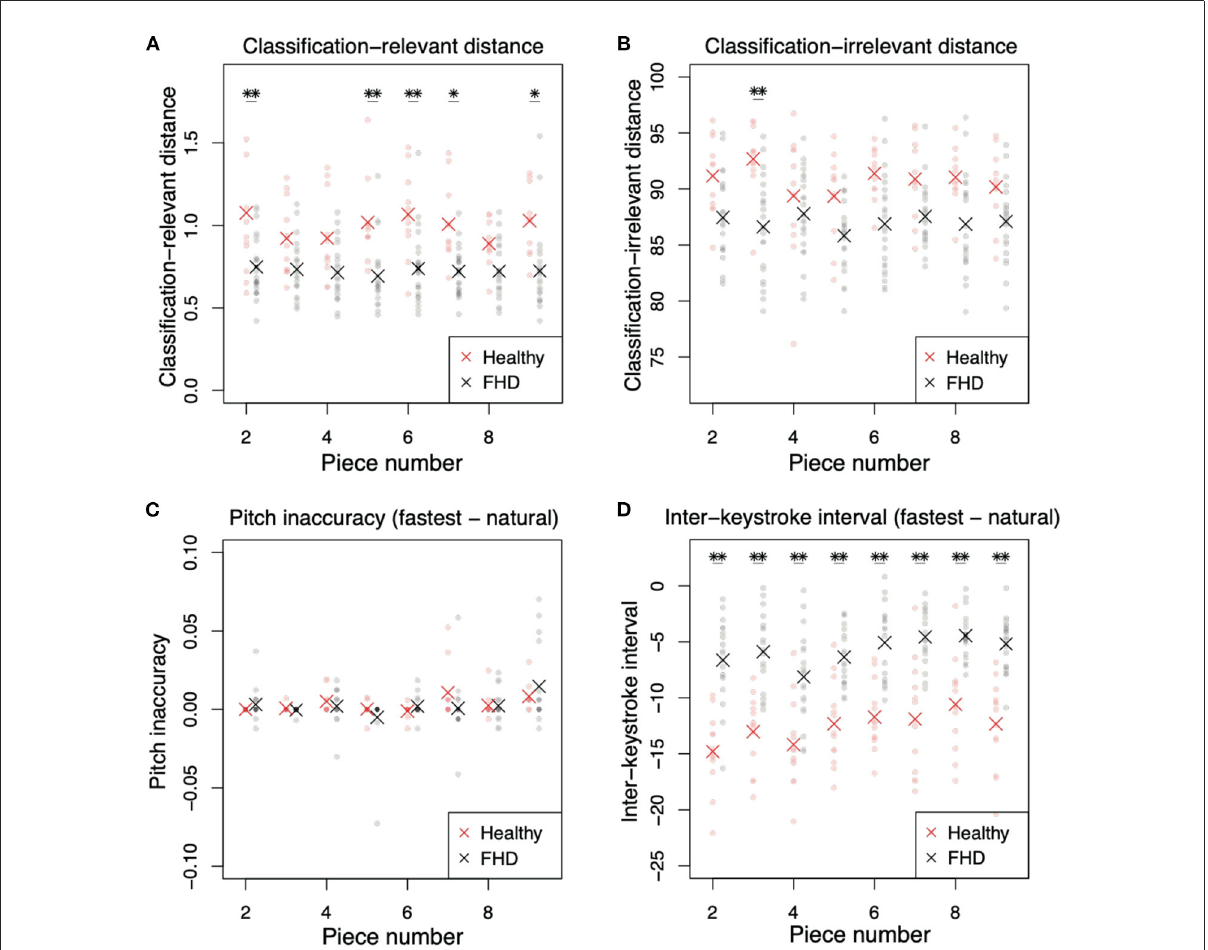
FIGURE6 Comparisons of classification-relevant distance, classification-irrelevant distance, pitch inaccuracy, and interkeystroke interval between healthy pianists and patients with FHD for pieces #2-#9. (A) Classification-relevant distance between participants in the two groups. Red and black dots denote the distances in each subject. Asterisks indicate mean classification-relevant distances in each group. Single and double asterisks indicate significant differences based on p < 0.05 and p < 0.01, respectively. (B) Classification-irrelevant distance. (C) Pitch inaccuracy in playing at the natural tempo subtracted from the inaccuracy in playing at the fastest tempo. (D) Interkeystroke interval in playing at the natural tempo subtracted from the inaccuracy in playing at the fastest